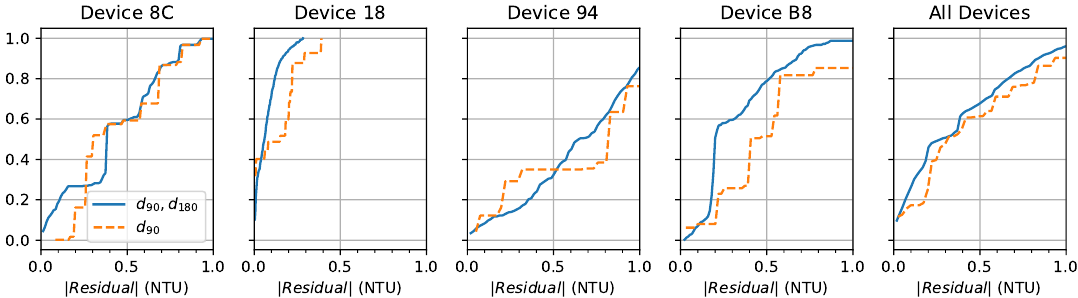
Figure 11. Cumulative distribution function of the absolute value of the residual by